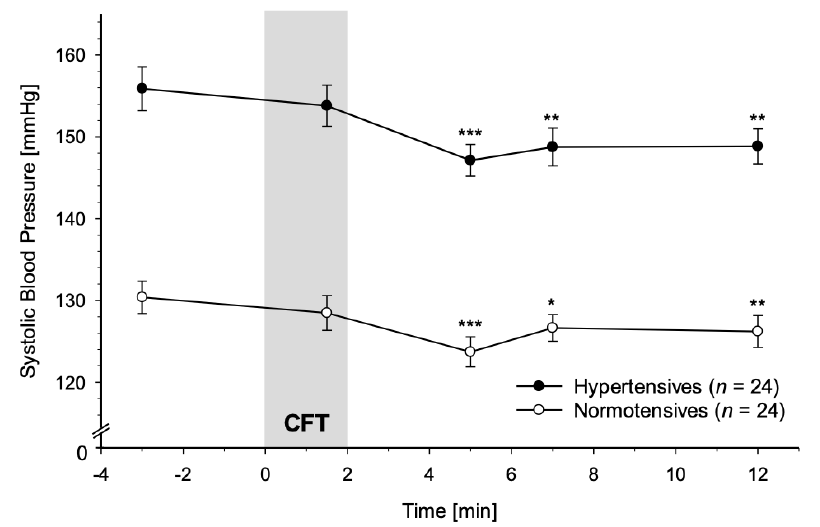
Figure 1. Systolic Blood Pressure (SBP) response to Cold Face Test (CFT; grey bar) in hypertensive participants (black dots) and normotensive controls (white dots) (mean ± SEM). A repeated measures ANOVA revealed that SBP reactivity did not differ between hypertensives and normotensives (interaction group-by-time: p = 0.44) except for the higher overall SBP in hypertensives (main effect of group: p < 0.001). Repeated measures ANOVAs calculated separately in hypertensives and normotensives revealed main effects of time in both groups ( p ′ s < 0.001). Asterisks indicate significant differences between measurement timepoints during/after CFT and the respective baseline levels within each group (* p < 0.05; ** p < 0.01; *** p < 0.001).